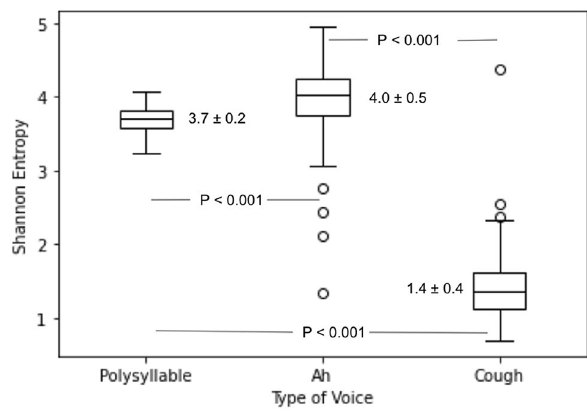
Figure 2. Shannon entropy of the 3 voice